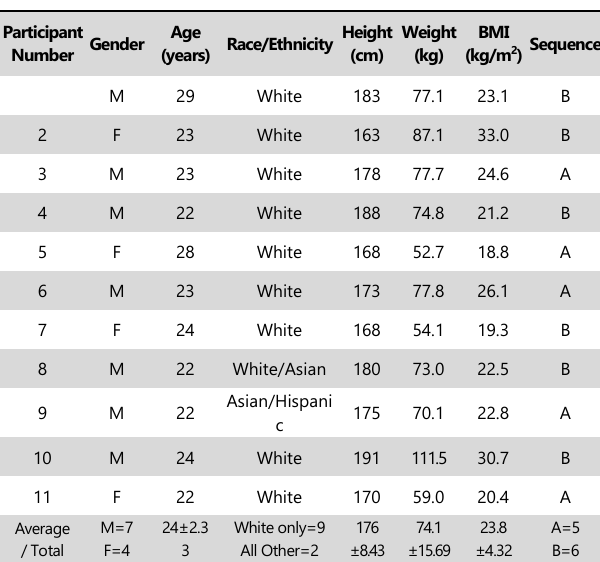
Table 1 . Participant Characteristics of the Sample of Non-disabled Young Adults